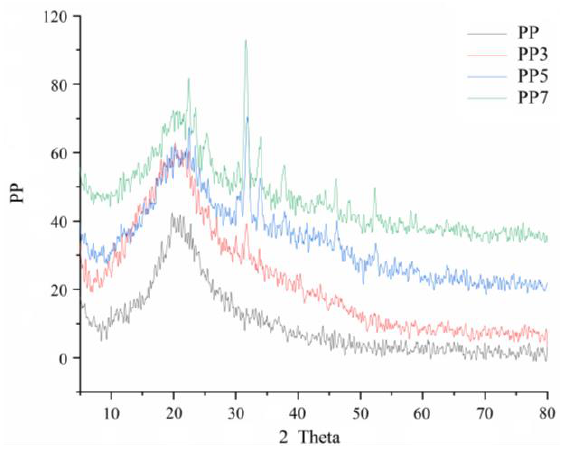
Figure 5. X-ray diffraction pattern of PP, PP3, PP5, and PP7.